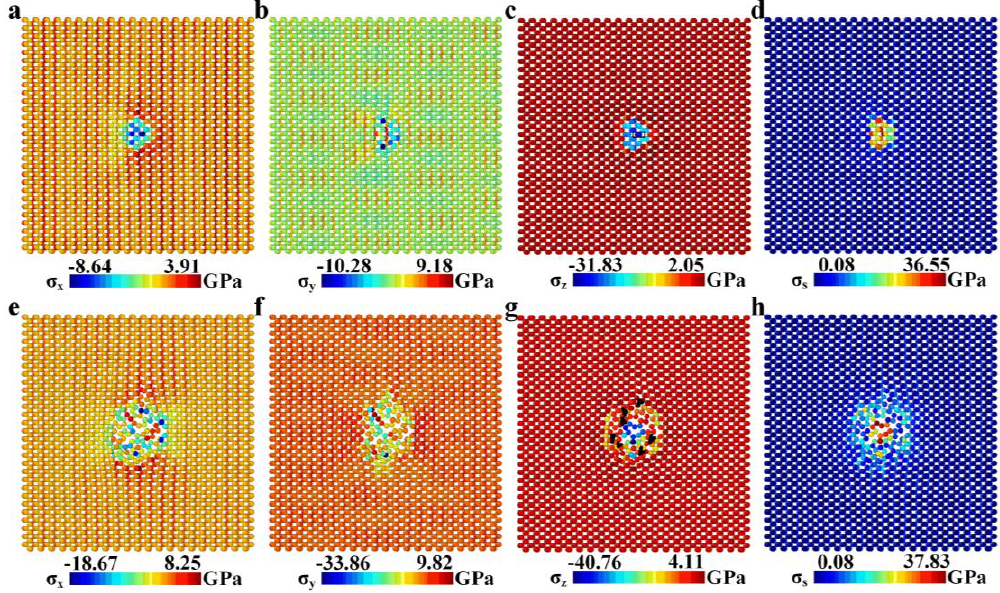
Figure 6. ( a – d ) Distribution of σ x , σ y , σ z and σ s in the Pt(111)-supported BP monolayer at the end of elastic deformation (corresponding to point A in Figure3a); ( e – h ) Distribution of σ x , σ y , σ z and σ s in the Pt(111)-supported BP monolayer at plastic deformation stage (corresponding to point C in Figure 3a). The black sharp angles in Figure 6g represent the crack propagation tips.